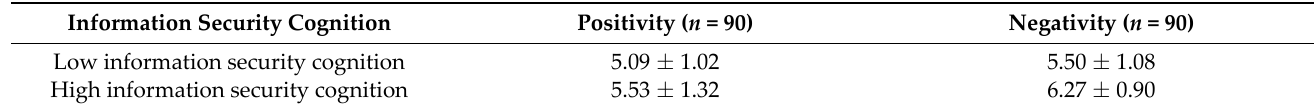
Table 7. Mean Comparison of Information Security Cognition and Nature (Mean ± Standard Devi‑ Table 6. Results of Two-Way ANOVA. ation).